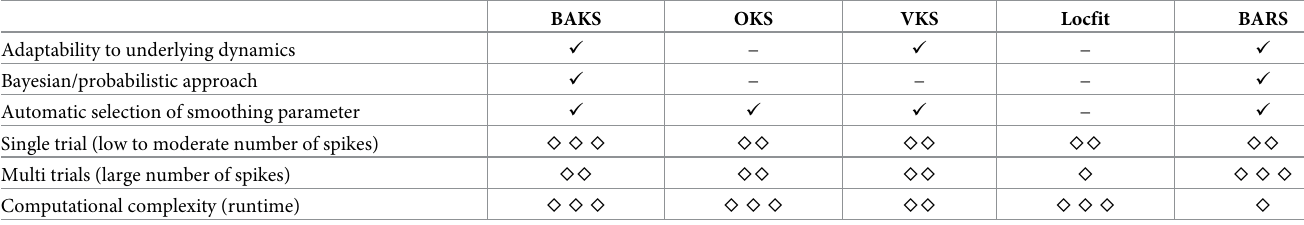
Table 3. Comparison summary of BAKS with other